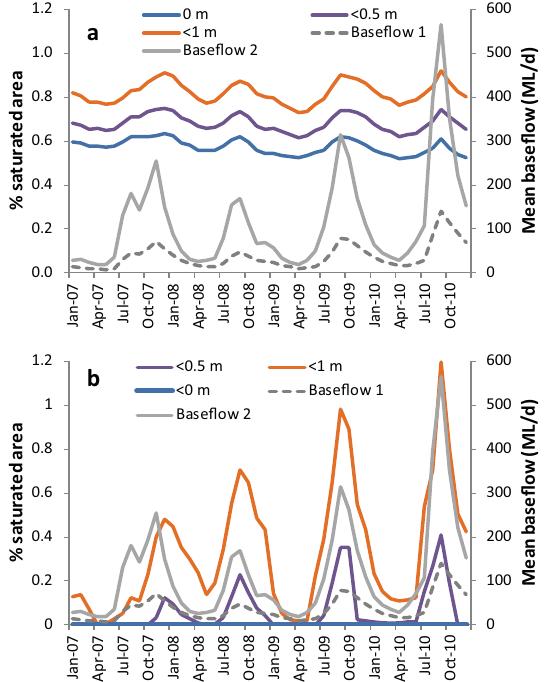
Figure 6. Percentage saturated area (intersection of groundwater surface with land surface) variations over time for the potentiomet- ric (all bores) data set (a) and the water table (33 bores) data set (b) for the catchment area with elevation < 100m. The position of the water table is shown for three depths (0, 0.5, 1.0m) to al- low for uncertainties in the mapping of the depth to water table. The mean daily baseflow for each month is shown for two sets of Eckhardt filter parameter values calculated from the Bunker Hill gauging record. Baseflow 1 uses the low BFI max value ( a = 0 . 988, BFI max = 0 . 20), while Baseflow 2 uses a higher BFI max value ( a = 0 . 988, BFI max = 0 .